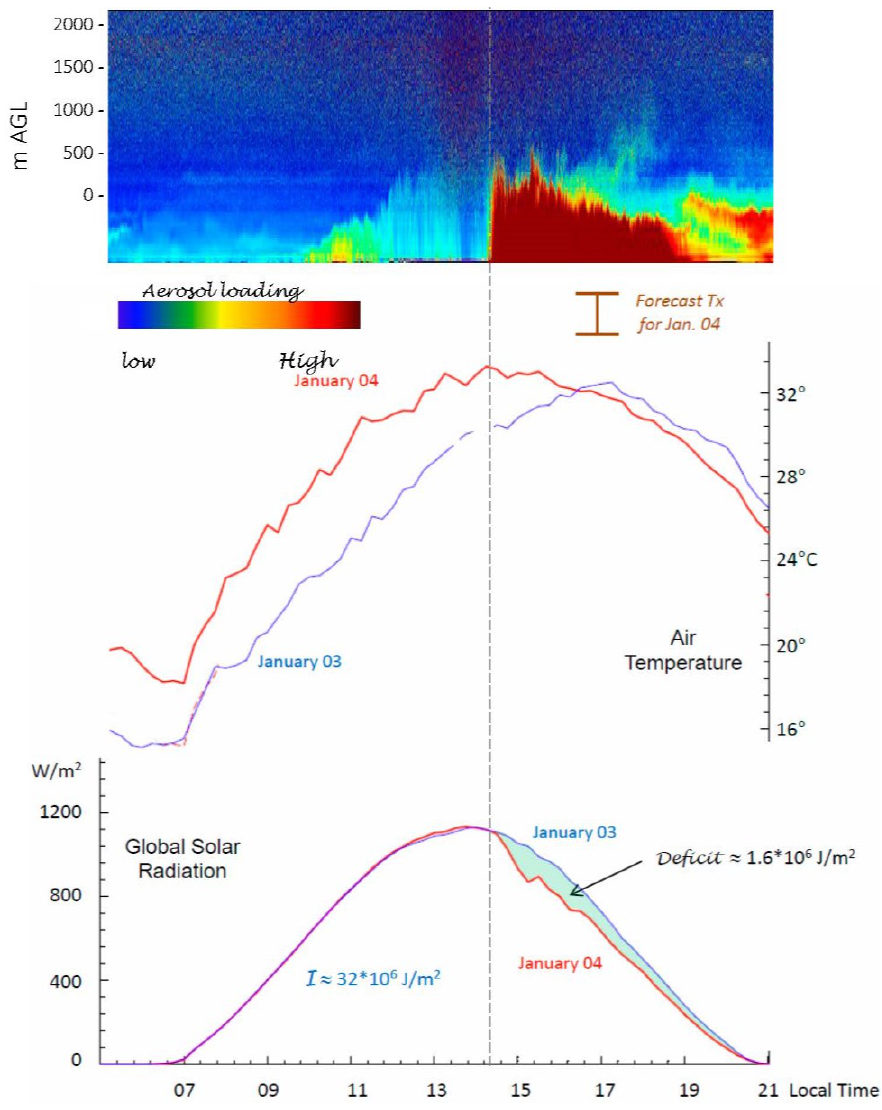
Figure 4. Upper panel: Time-height diagram of the backscatter reflectivity from a laser ceilometer (VAISALA CL-31) located at Santiago downtown during 4 January 2014 (active fire). The reflectivity has been related with the aerosol loading in the mixed layer [27] which is qualitatively indicated here from low to high. Middle panel: Air temperature 4 January (solid red line) and the previous day (3 January, blue line). Lower panel: Global solar radiation reaching the surface at Santiago for 3 January (blue line) and 4 January (red line).